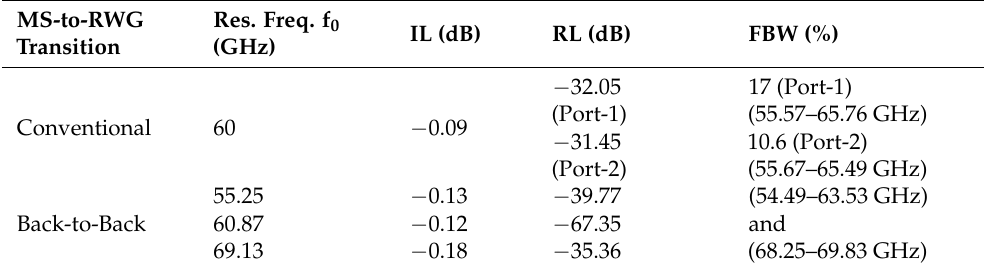
Figure 7. RL and IL plots of the conventional and B2B designed transitions. Table 5. Resultant performance parameters of the V-band-designed MS-to-RWG